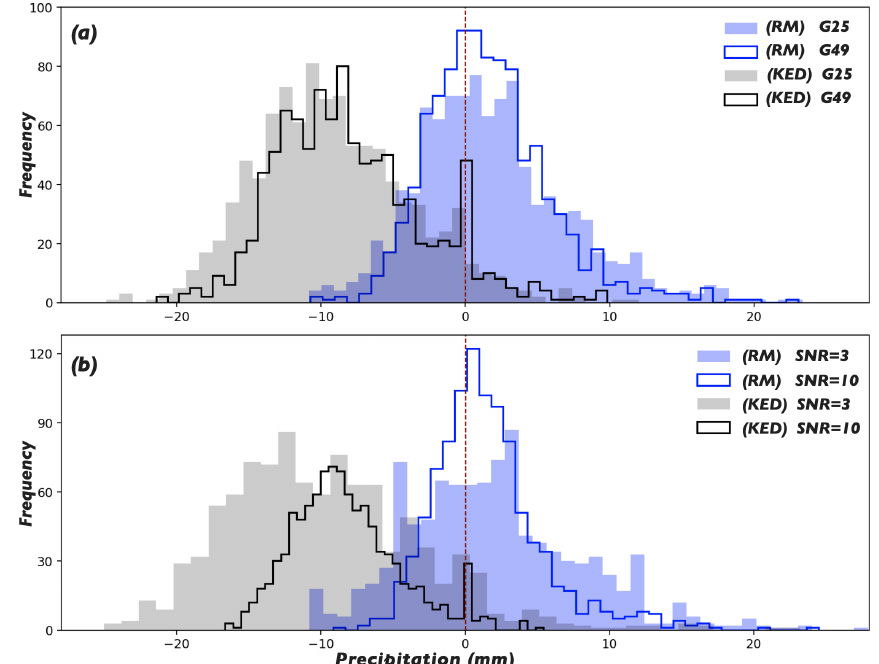
Figure 9. Histograms of the errors w.r.t. the estimated field maxima for the 1000 true rainfall fields obtained by RM and KED. (a) The results for the scenarios with different rain gauge layouts, with the random error in the radar estimates fixed at SNR = 5. (b) The results for the scenarios with different levels of random error in the radar estimates, with the rain gauge layout fixed at G36.